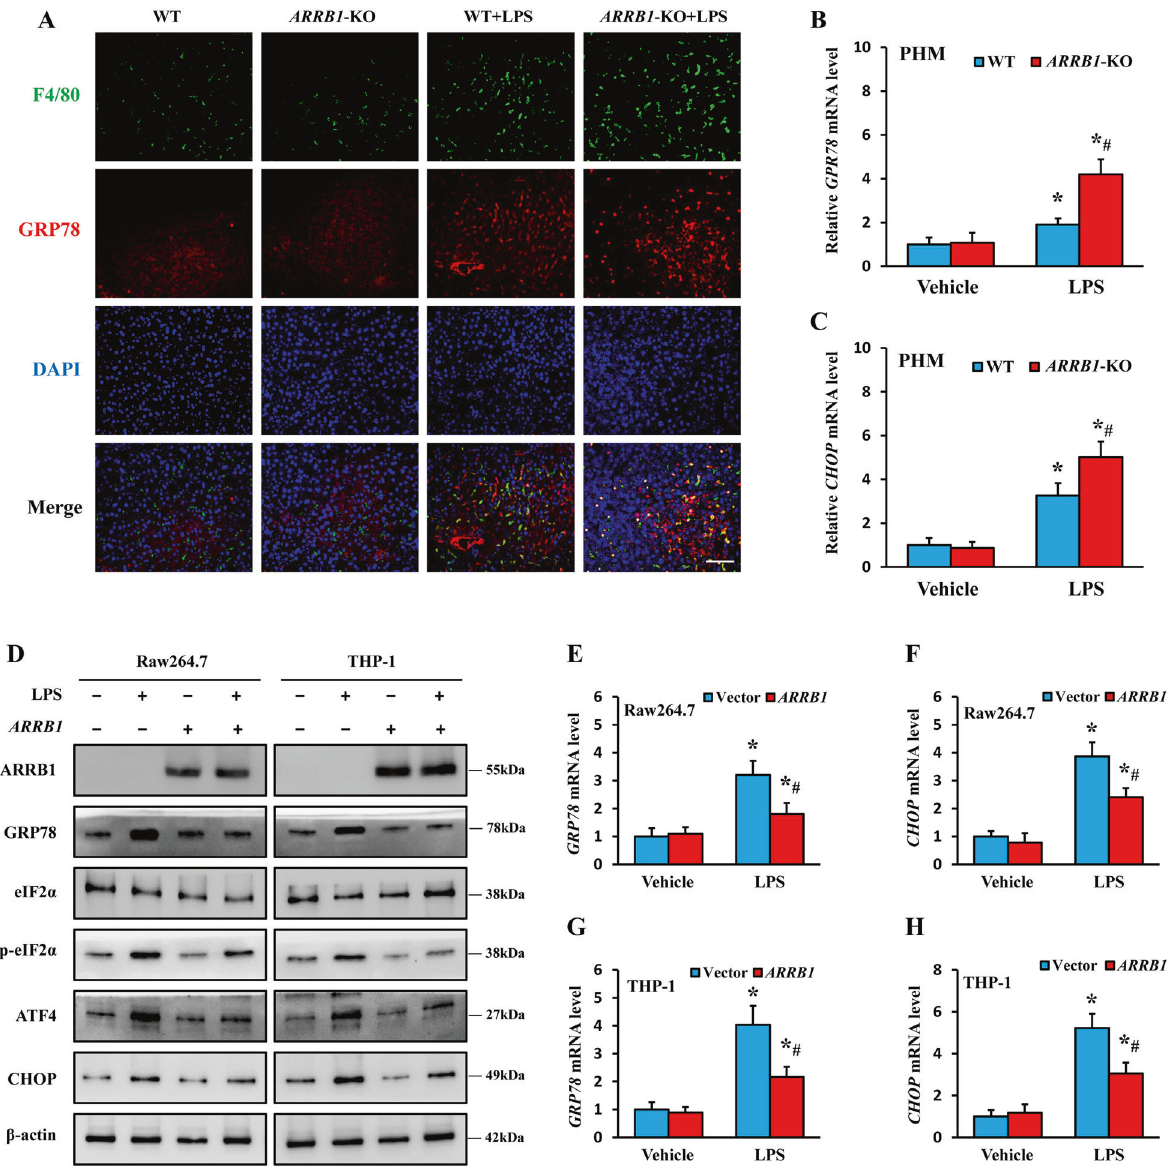
red. The merged positive signals of F4/80 and GRP78 are visualized in yellow (scale bar: 50 μ m). B , C GRP78 and CHOP mRNA levels in primary hepatic macrophages with LPS (0.5 μ g/ml) challenge for 6 h from WT and ARRB1 -KO mice were analyzed by real-time PCR. * P < 0.05 compared with the respective vehicle treatment; # P < 0.05 compared with LPS-induced WT mice by Student ’ s t test. D Protein expression levels of ARRB1, GRP78, eIF2 α , p-eIF2 α , CHOP, and ATF4 in ARRB1 -overexpressing Raw264.7 and THP-1 cells with or without LPS (1 μ g/ml) challenge for 6 h. E – H GRP78 and CHOP mRNA levels of ARRB1 -overexpressing Raw264.7 and THP-1 cells with LPS (1 μ g/ml) were challenged for 6 h and analyzed by real-time PCR. * P < 0.05 compared with the respective vehicle treatment; # P < 0.05 compared with vector cells following LPS treatment by Student ’ s t test. Data are presented as the mean ± SD of three separate